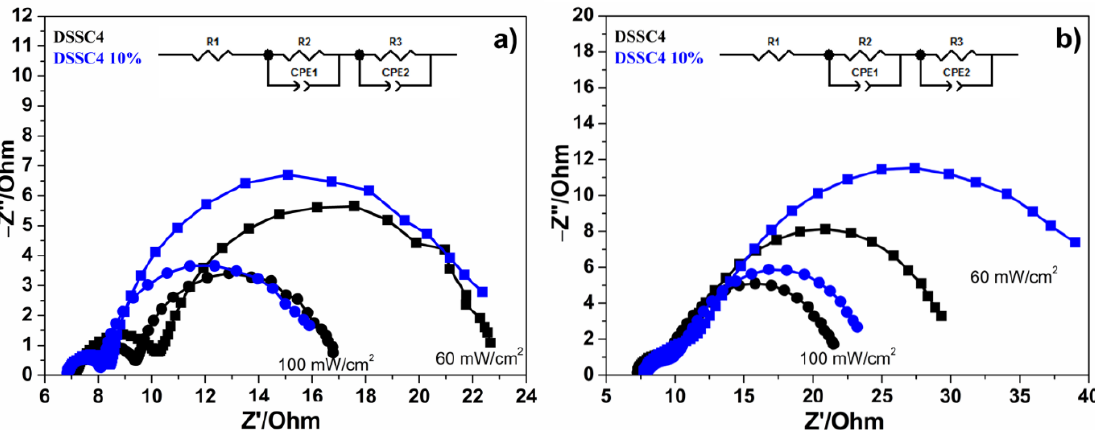
Figure 14. Impedance spectra of ( a ) DN-F01and ( b ) curcumin sensitized DSSC4 with E and E10% electrolytes under 60 mW/cm 2 and 100 mW/cm 2 of the illumination intensity. The inset shows the equivalent circuit diagram used to fit the observed impedance spectra.